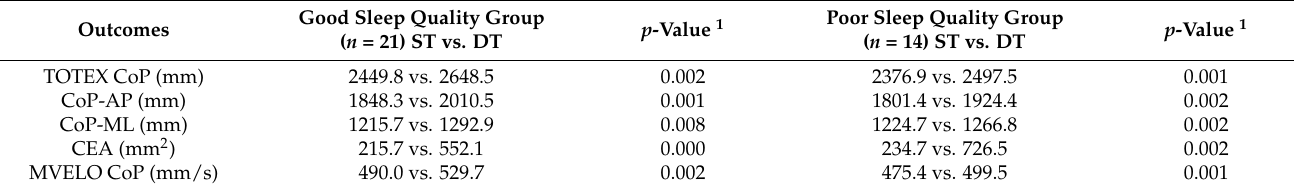
poor sleep quality group, median and p -values.